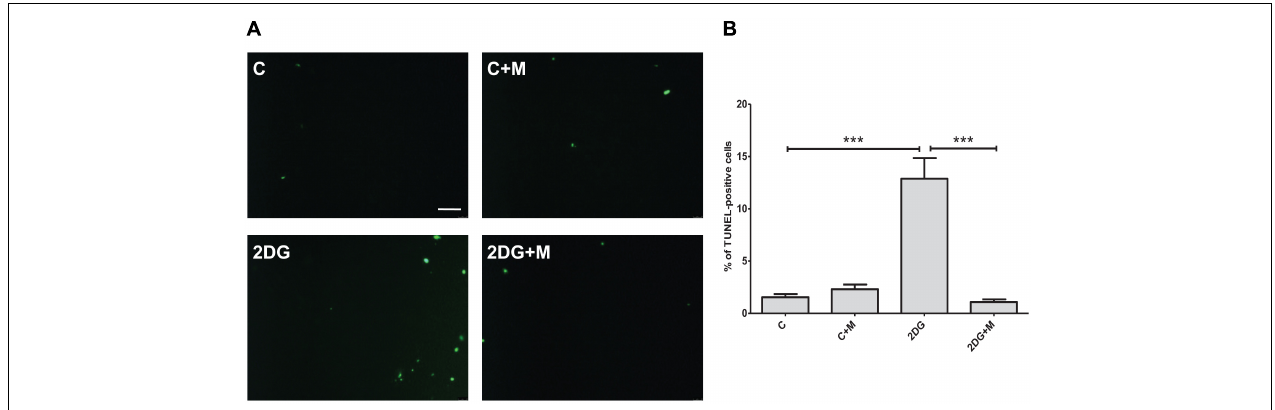
FIGURE 3 | Metformin abolishes cell apoptosis in response to metabolic stress. (A) Representative images of TUNEL staining of cultured H9C2 cells exposed to 2 mM 2-deoxyglucose (2DG) in the presence or absence of 5 mM metformin (M). (B) Quantification of apoptosis from (A) . Scale bar is 100 µ m. Data represents the mean ± SEM from at least three independent experiments. Statistical analysis was carried out by one-way ANOVA: ∗∗∗ P < 0.001 between indicated conditions.